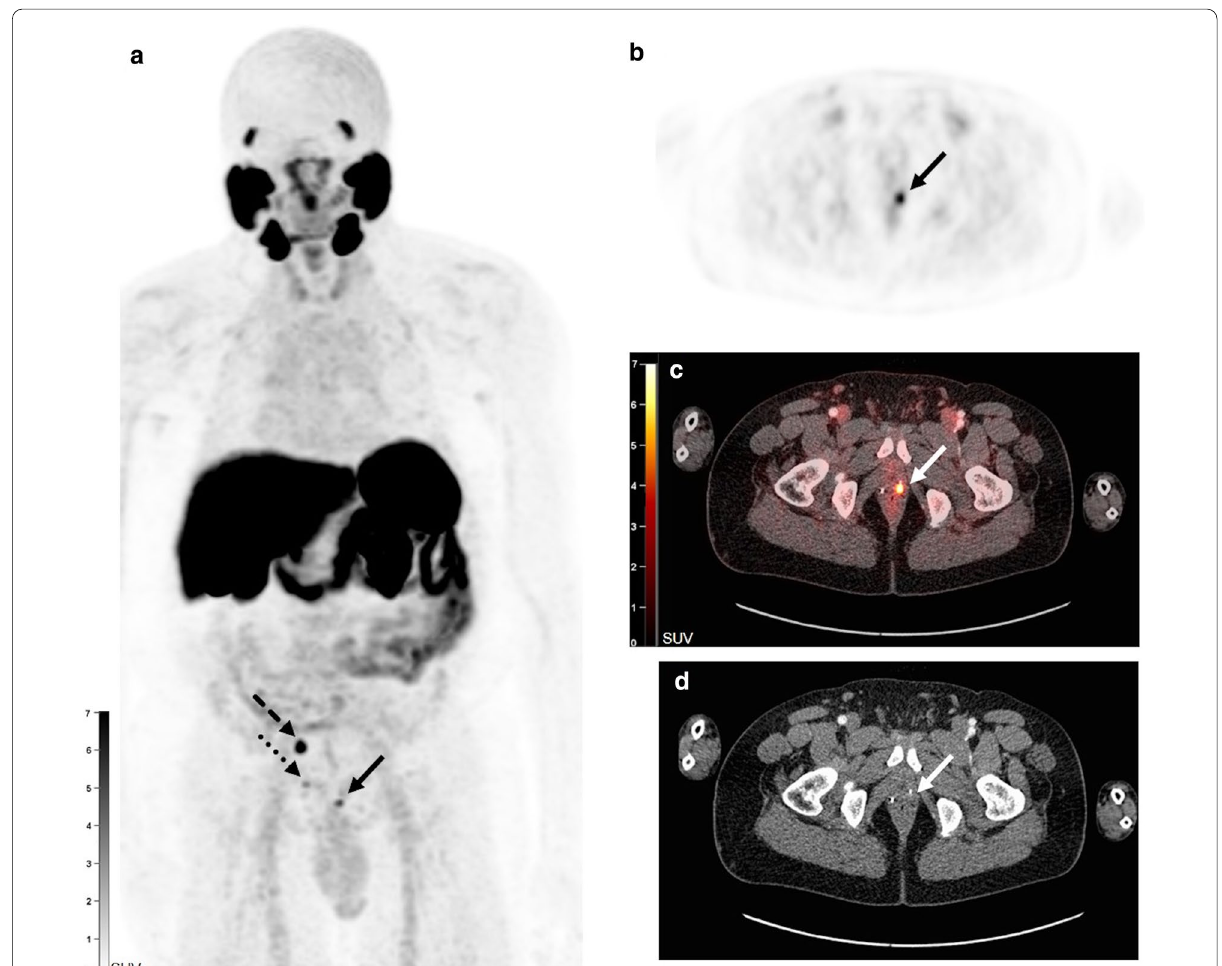
Fig. 1 [ 18 F]PSMA-1007-PET/CT scan (MIP image ( a ) and transversal PET ( b ), fusion ( c ) and CT images ( d )) in a 64-year old patient with a medical history of radical prostatectomy with extended lymphadenectomy (Gleason score 9, pT3bN0). PSA value at the moment of [ 18 F]PSMA-1007-PET/ CT scan was 2.27 ng/ml. A local recurrence was detected in the prostatectomy fossa on the left side ( a – d , full arrow) and in the right seminal vesicle ( a , dotted arrow). Also, a malignant lymph node was visible at the right internal iliac artery ( a , dashed arrow). The patient was treated with salvage external beam radiation therapy and androgen deprivation therapy with subsequent decline of PSA to 0.01 ng/ml 7 months